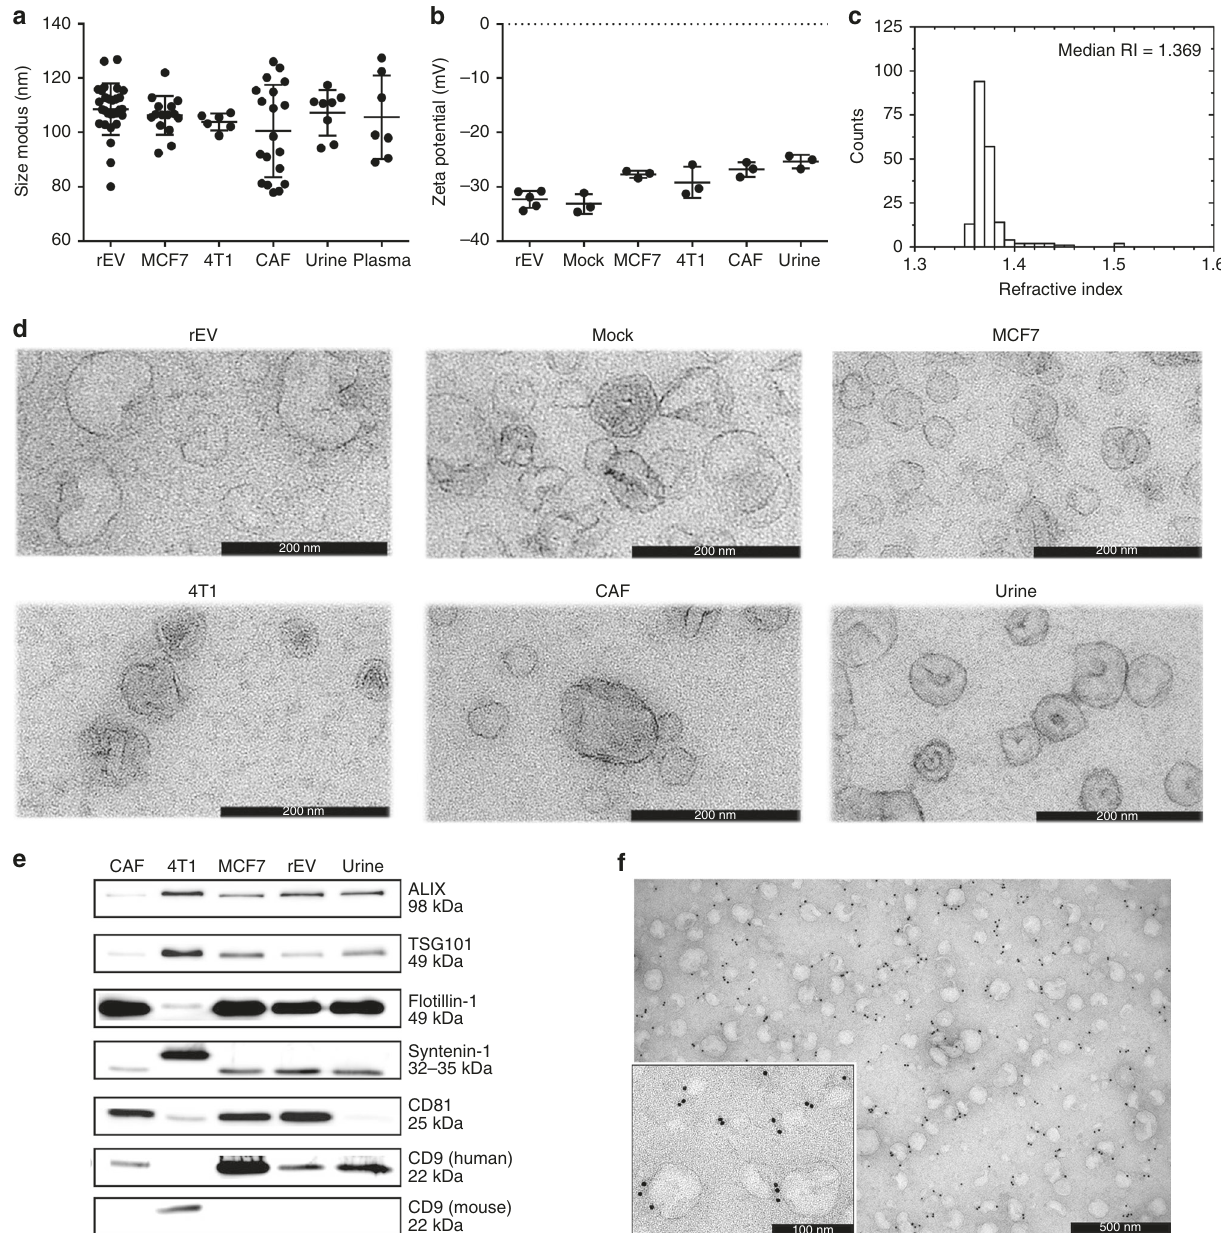
Fig. 2 rEV bear physical and biochemical traits characteristic of sample EV. rEV, separated by ODG centrifugation of medium conditioned by gag-EGFP transfected HEK293T cells, are compared to sample EV separated by ODG centrifugation from different sources, including medium conditioned by breast cancer cells (MCF7, 4T1), mock transfected HEK293T cells (mock) or cancer-associated fi broblasts (CAF) or plasma and urine for a size distribution measured with nanoparticle tracking analysis (NTA) ( n > 6), b zeta potential ( n > 3), c refractive index distribution calculated with NTA and MIE theory (supplementary fi g. 3a), d morphology as imaged by transmission electron microscopy (TEM) and the presence of EV-associated proteins ALIX, TSG101, fl otillin-1, syntenin-1, CD81, CD9 and CD63 analysed by e western blot analysis (30 μ g protein loaded on gel) and f immune-electron microscopy with a secondary gold labelled antibody against a primary antibody targeting the extracellular loop of the tetraspanin CD63. Images are representative of three biological replicates. Data in a and b are (mean, SD). Source data are provided as a source data fi